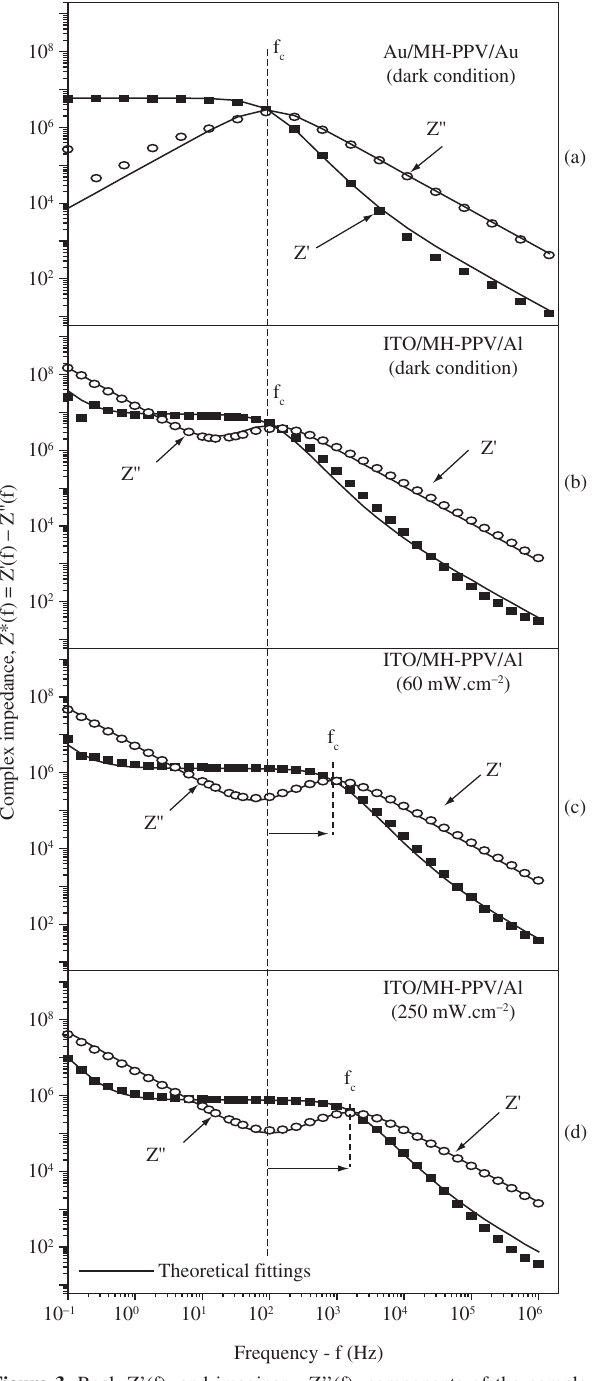
Figure 3. Real, Z’(f), and imaginary, Z’’(f), components of the complex impedance for Au/MH-PPV/Au and ITO/MH-PPV/Al samples. The measure- ments were carried out in the dark for Au-Au (Figure 3a) sample, and in the dark (Figure 3b), at 60 mW.cm –2 (Figure 3c) and at 250 mW.cm –2 (Figure 3d) for ITO-Al